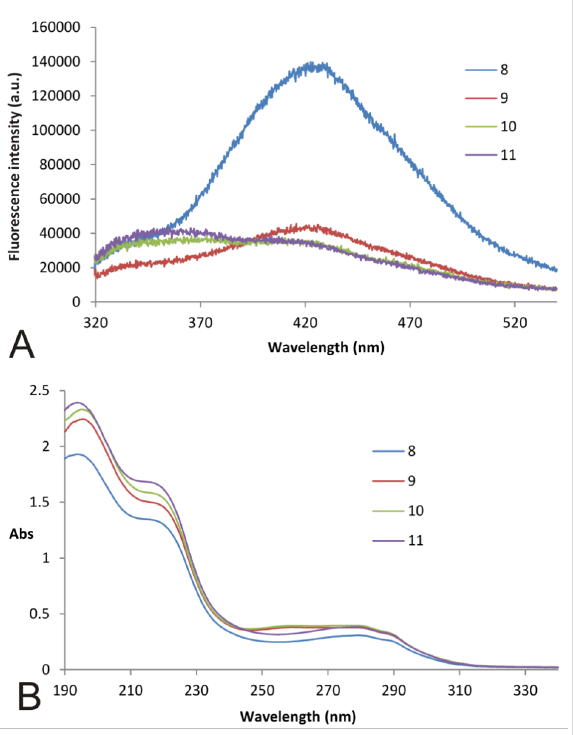
Figure 3: A) Fluorescence spectra of compounds 8 – 11 in water (1 × 10 − 5 М ), B) UV spectra of aqueous solutions of thiacalix[4]arenes 8 – 11 (1 × 10 − 5 М ).